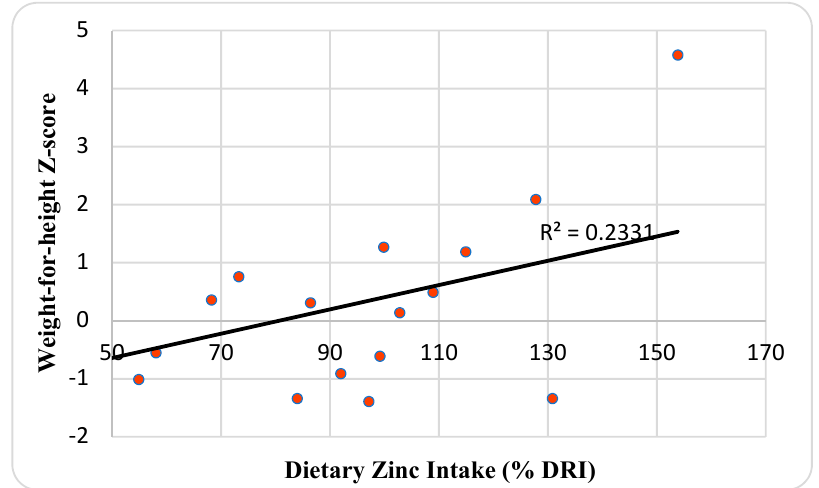
Figure 5. Relationship between dietary zinc intake and weight-for-height Z-score. %DRI: Percentage of Dietary Reference Intake.